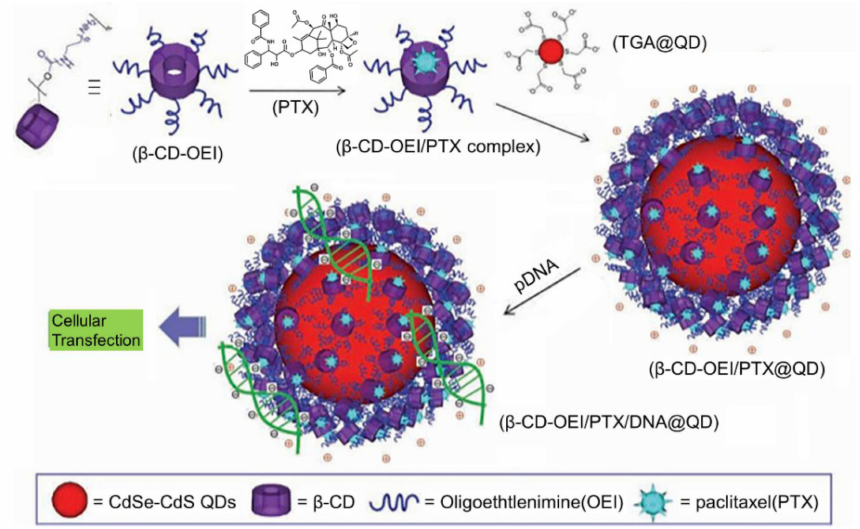
Figure 7. Schematic representation of the fabrication of multifunctional hybrid nanocarrier with simultaneous paclitaxel/gene co-delivery and cellular imaging functions. Adapted with permission from Ref.